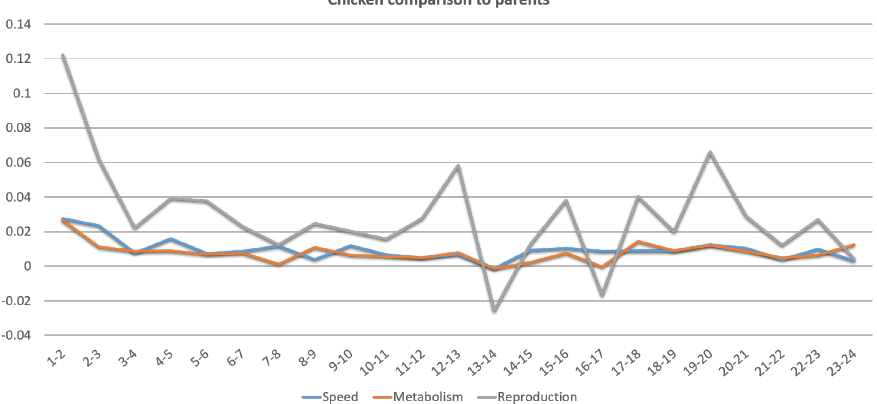
Figure 25. The diagram shows a comparison between the new and the old generations. On the vertical axis the parent’s best values were subtracted from the children values. Except for two cases, the new generations had better attributes than their